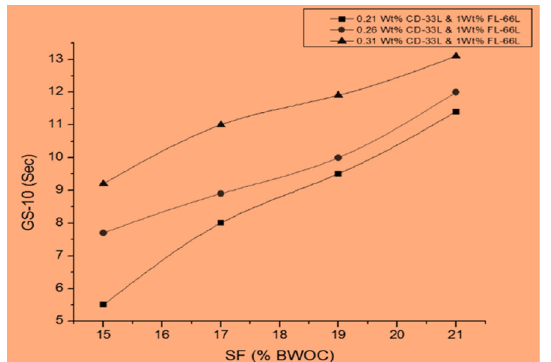
FIG. 8. COMBINED ADDITIVE EFFECTS ON GS-10 SEC OF 13 PPG SLURRY